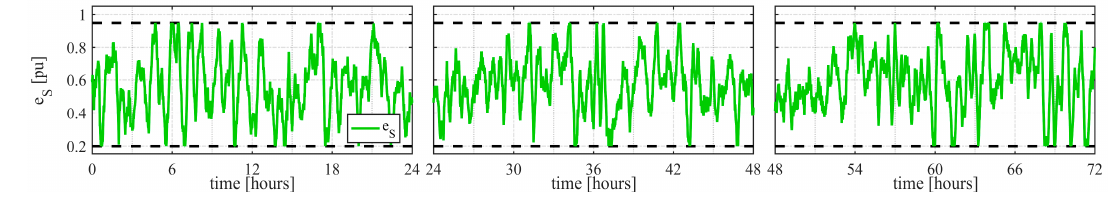
Figure 11. The S energy evolution achieved by the proposed OPEM over three days.